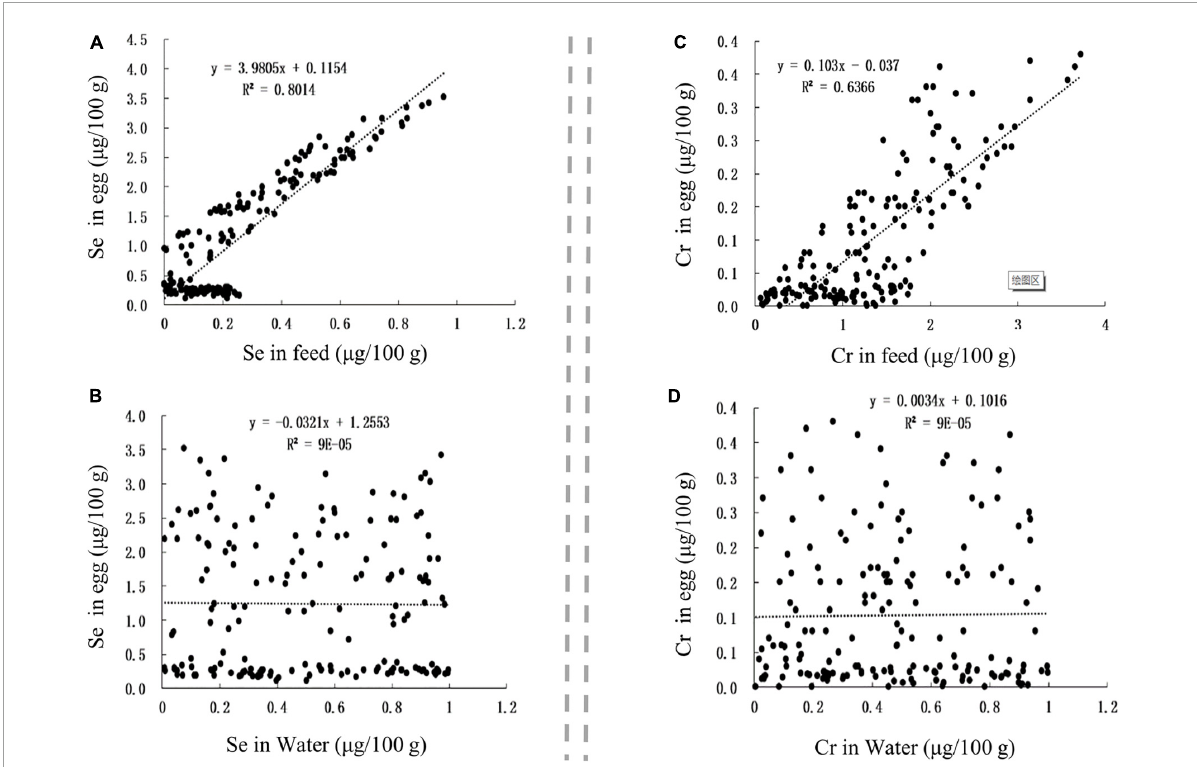
FIGURE6 The influence of factors on Se and Cr contents in egg. (A,B) The influence of Se content in feed and Se content in water on Se content in egg, respectively. (C,D) The influence of Cr content in feed and Cr content in water on Cr content in egg, respectively.